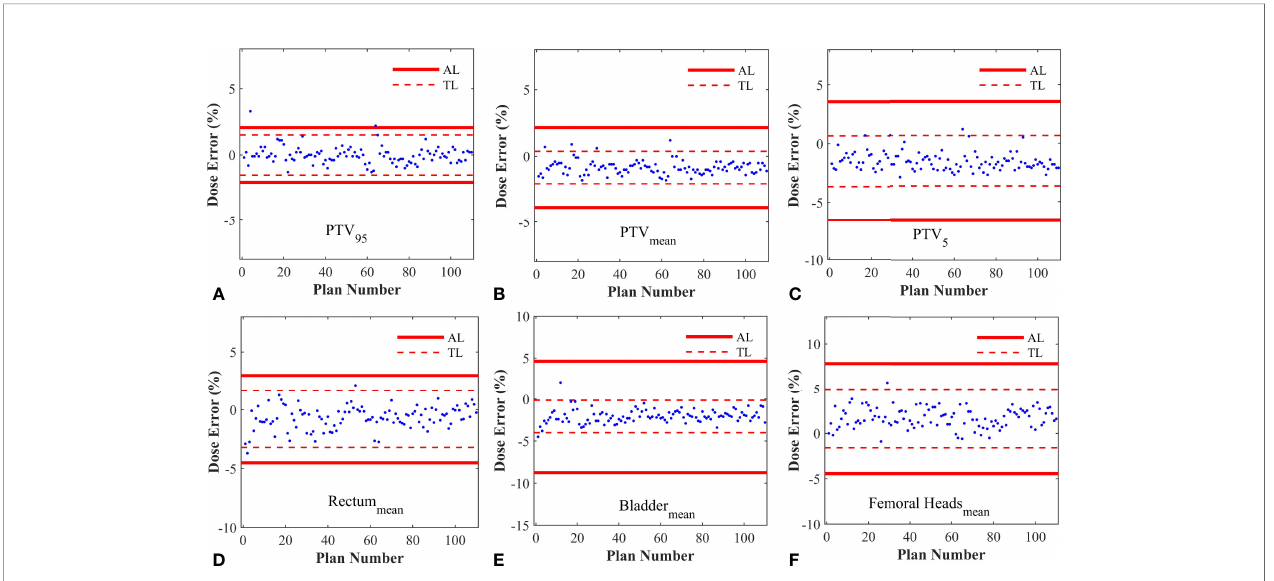
FIGURE 3 | The control charts obtained from different DVH metrics. (A) The control chart of PTV 95 ; (B) The control chart of PTV mean ; (C) The control chart of PTV 5 ; (D) The control chart of Rectum mean ; (E) The control chart of Bladder mean ; (F) The control chart of Femoral Heads mean . AL, Action limits; TL, Tolerance limits.